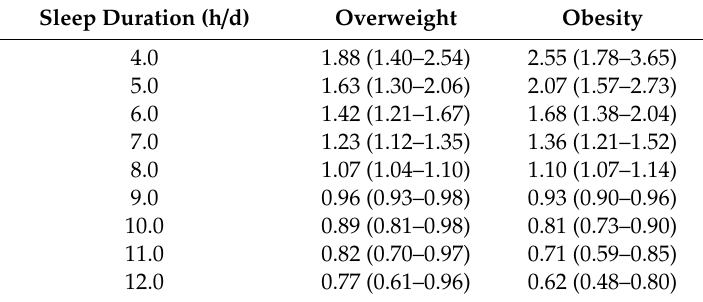
Figure 1. Non-linear regression curves of associations of sleep duration with overweight ( A ) and obesity ( B ). Table 3. OR and 95% CI for the restrictive cubic splines RCS.